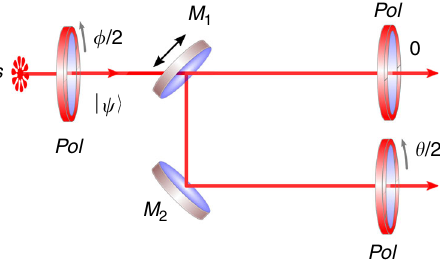
Fig. 1 The uncertainty principle illustrated by randomly oriented polarizers.